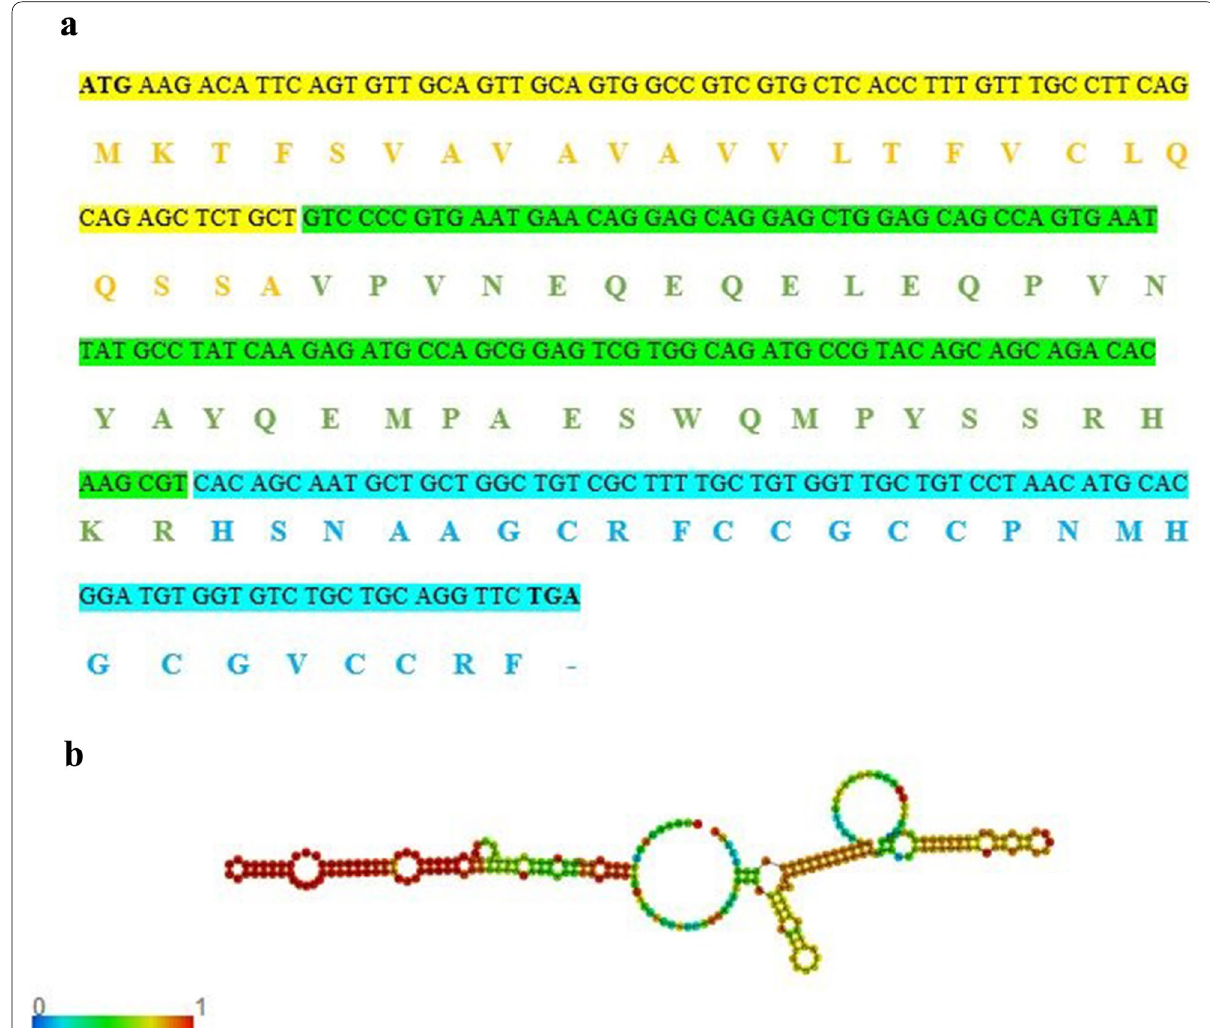
Fig. 1 a Nucleic acid and deduced amino acid sequences of Catla catla hepcidin, Cc -Hep (GenBank ID: MW854006). The single letter amino acid code is shown below the corresponding nucleotide sequences. Yellow color specifies signal peptide region, green color propeptide, and blue color mature peptide region. b mRNA structure of Cc -Hep showing stem loop structure. The mRNA structure colored by base-pairing probabilities. High base-pairing probability is indicated by red color and low base-pair probability indicated by blue